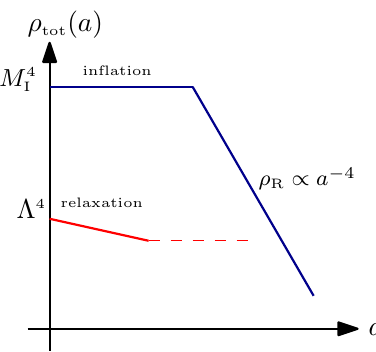
Sketch of the energy density of the universe as a function of the scale factor in the scenario discussed in section 3.1 where relaxation happens when the energy universe is dominated by the in(cid:13)aton